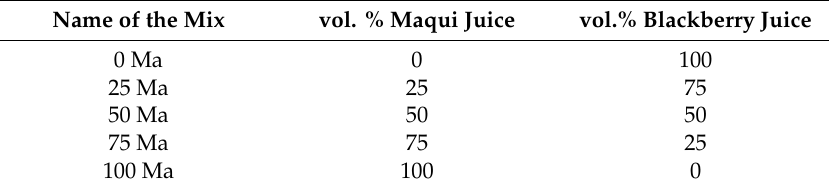
Table 4. Anthocyanin extract mixtures from maqui berry and blackberry. Name of the Mix vol. % Maqui Juice vol.% Blackberry